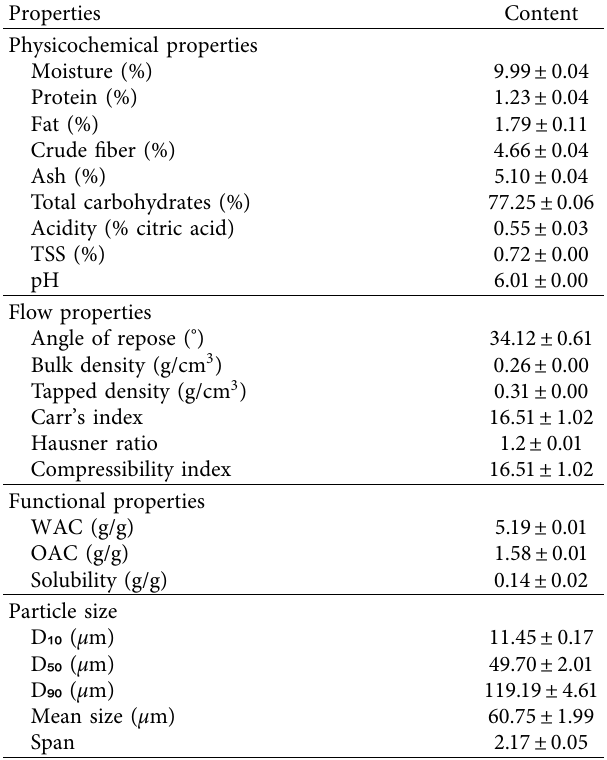
Table 5: Characteristics of optimized green banana four.